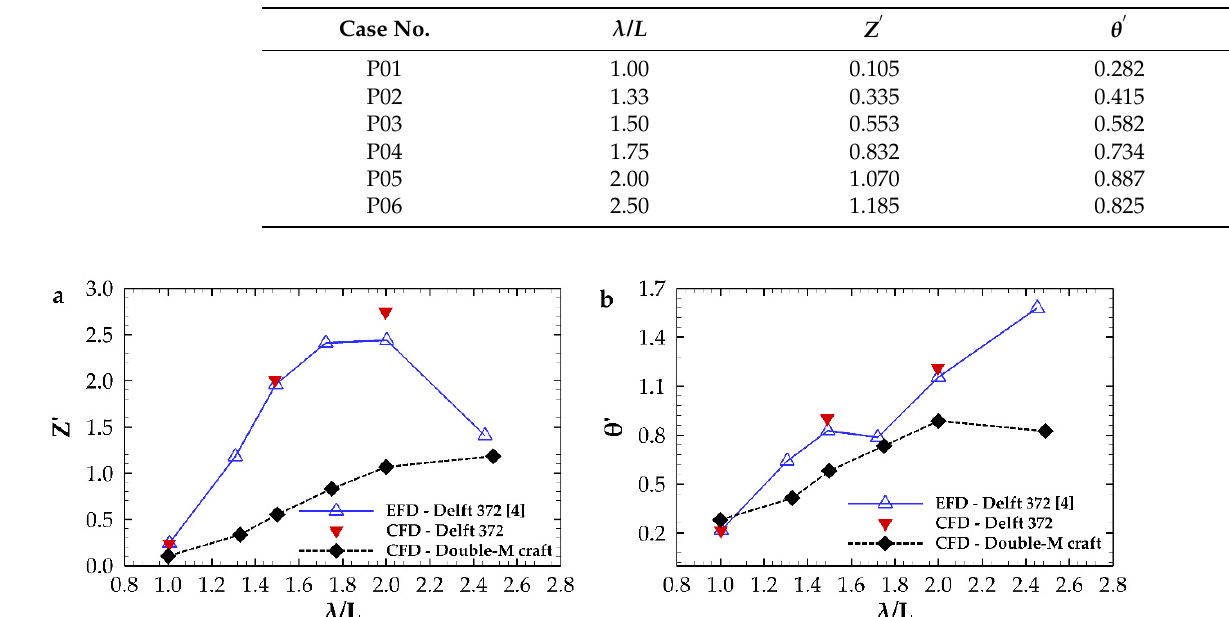
Table 9. The response amplitude operators of motion responses for the Double-M craft.